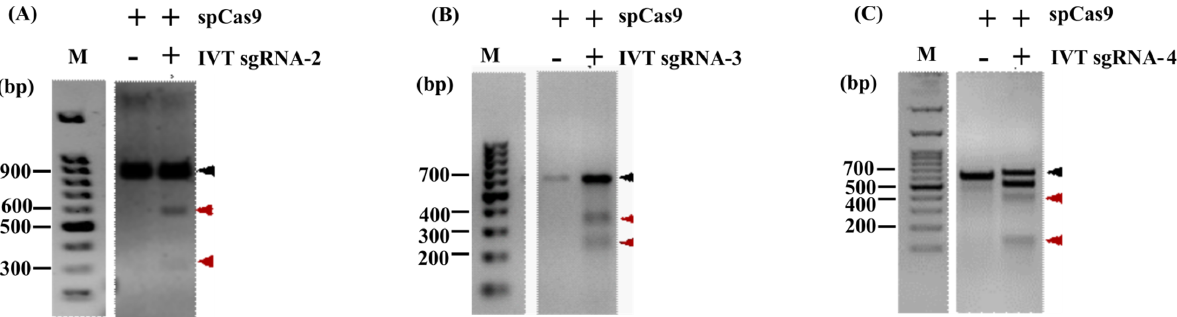
Figure 2. Cleavage assay. An in vitro cleavage assay with in vitro transcribed guide RNA products and spCas9 was carried out. ( A ) IVTsgRNA-2, ( B ) IVTsgRNA-3, and ( C ) IVTsgRNA-4. The respective amplicons were cleaved by spCas9 to yield bands of expected sizes, while sgRNA-1 did not express (not shown). The uncleaved DNA and cleaved fragments are indicated by black and red arrows, respectively. A 100 bp DNA ladder was run separately for each cleavage reaction and is shown for reference. Sizes of uncut and cleaved products are given in Table S2.